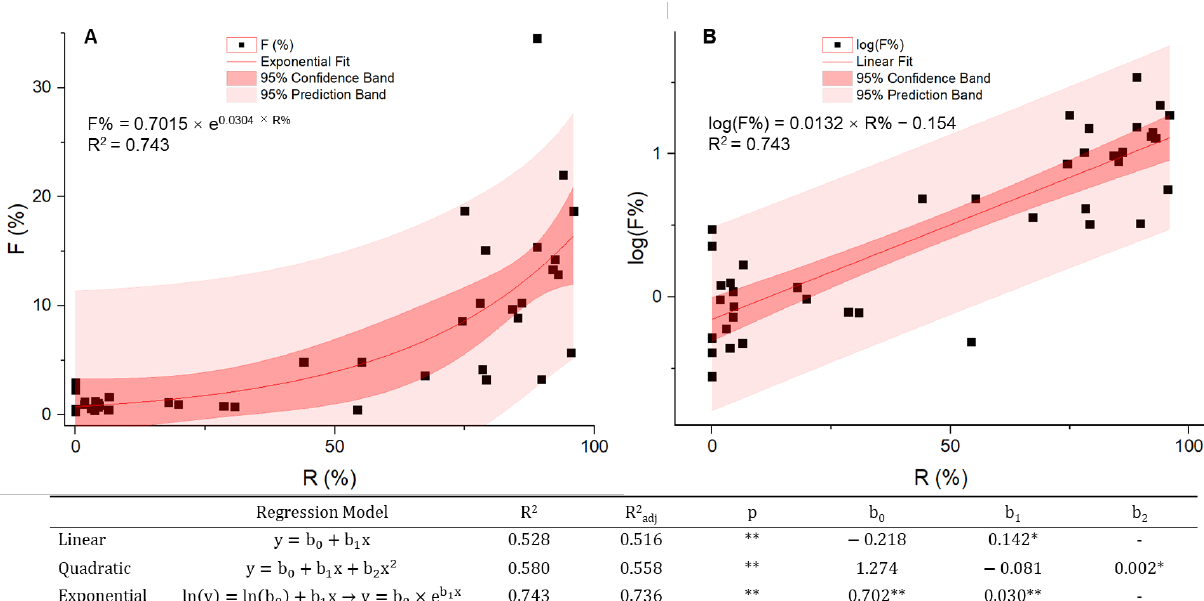
Figure 3. Correlations between R% and F%. Correlation analysis and curve estimation were performed with SPSS and presented on linear ( A ) and logarithmic ( B ) scales. Both data sets follow non-normal distributions, and the correlation coefficient was calculated using Spearman’s rank-order method. R% and F% are in strong positive correlation with the best fit in the exponential model.